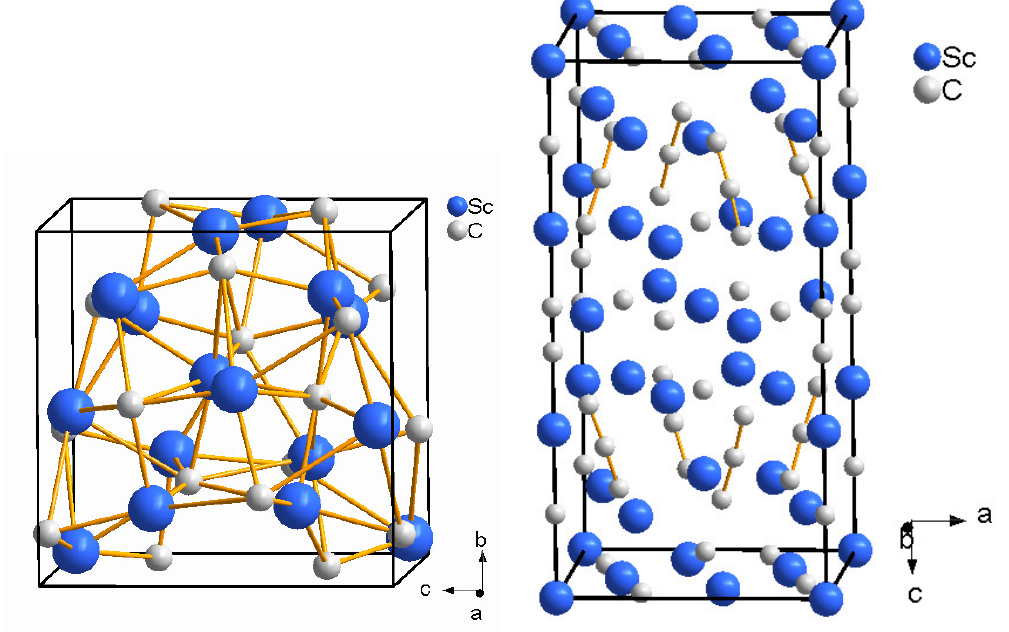
Figure 11. Crystal structures of Sc ( P 4 /mnc , right